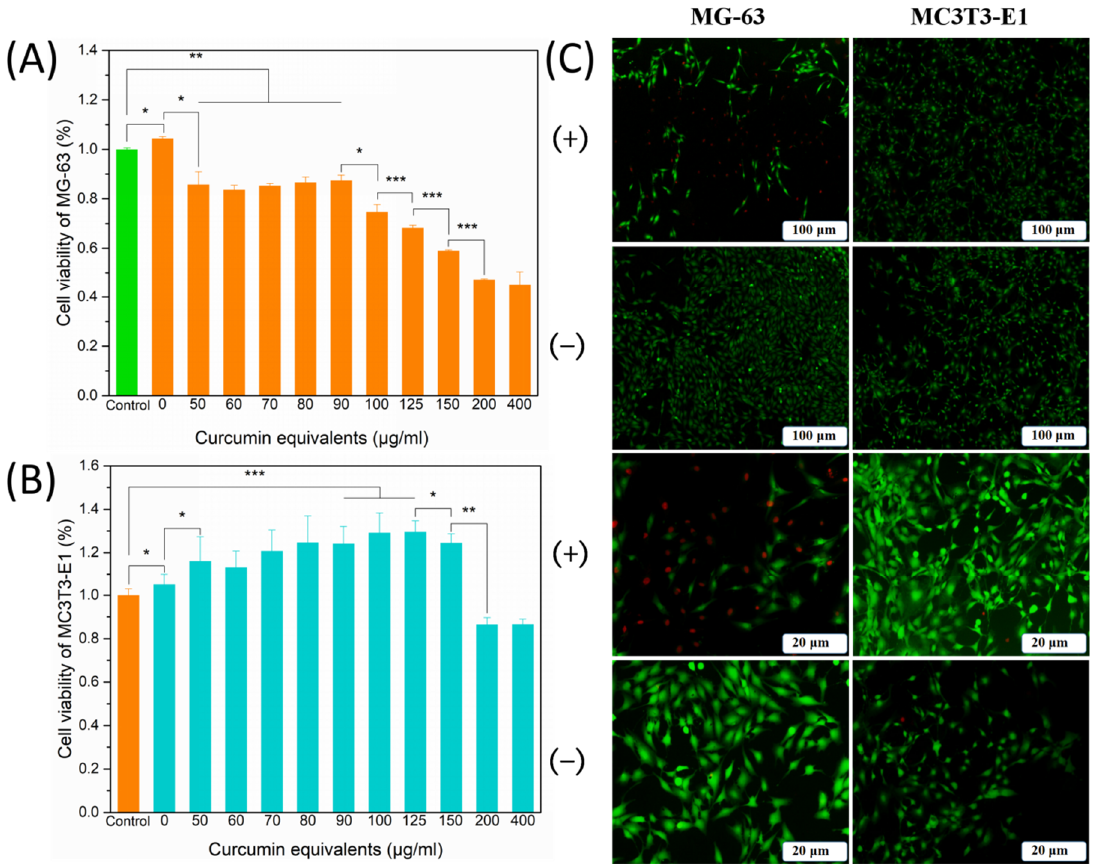
Figure 8. Cell viability of MG-63 ( A ) and MC3T3-E1 ( B ) cells after incubation with CCNPs-SF/HAMA hydrogels with different loading content for 48 h. Live and dead staining assay of cells with or without CCNPs-SF/HAMA hydrogels ( C ). Data are expressed as mean ± SD ( n = 6); * p < 0.05, ** p < 0.01, and *** p < 0.001 are differences between the indicated groups.